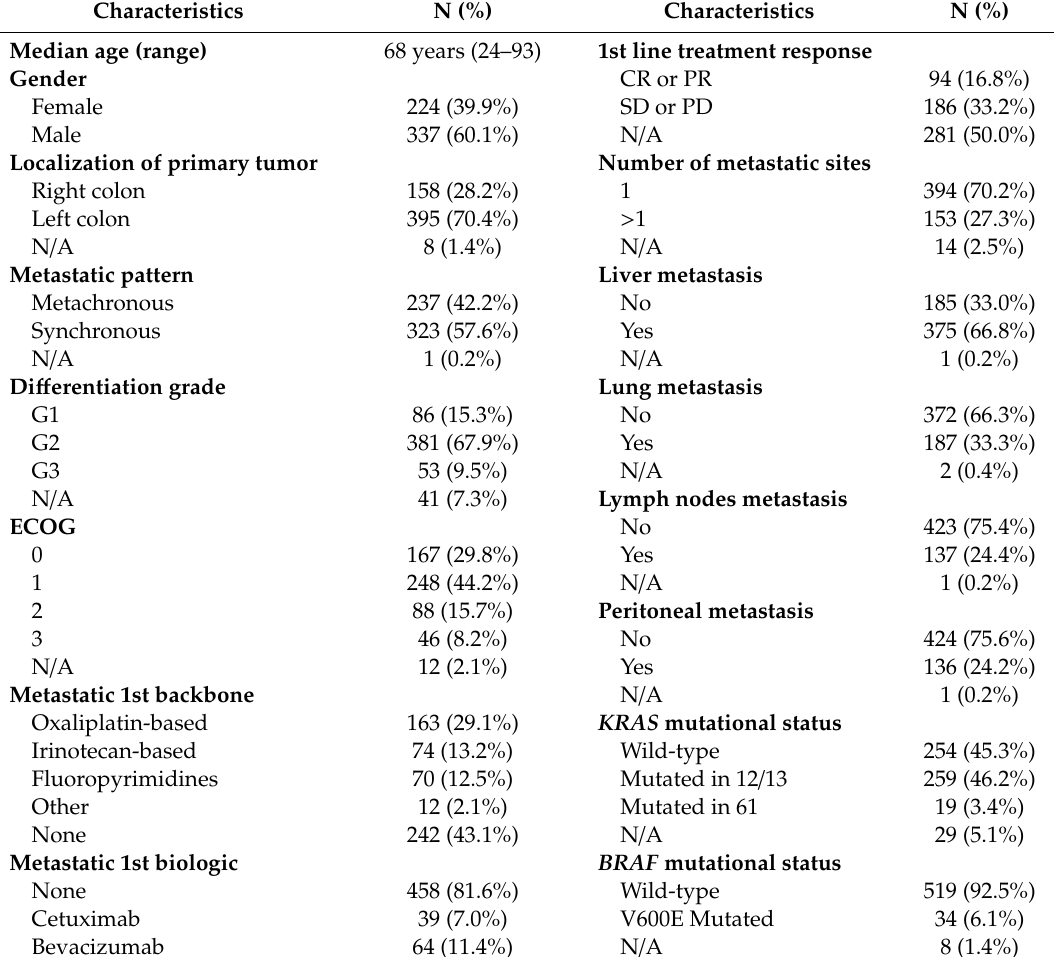
Table 1. Clinico-pathological characteristics of CRC patients from our institutional set included in the